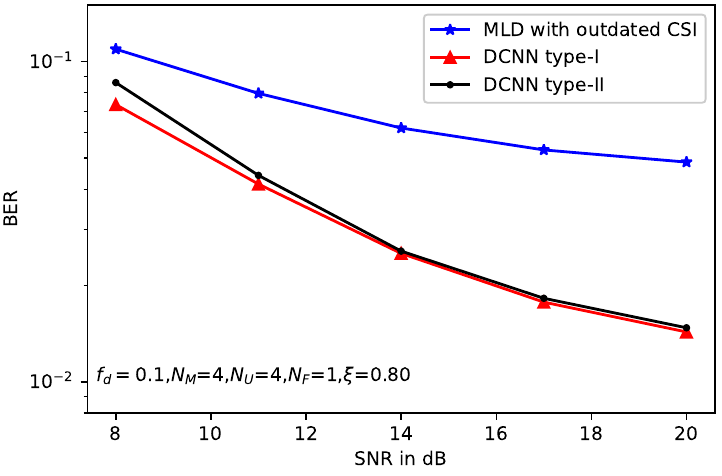
Figure 10. BER performance of deep learning-based MLD with N F = 1.